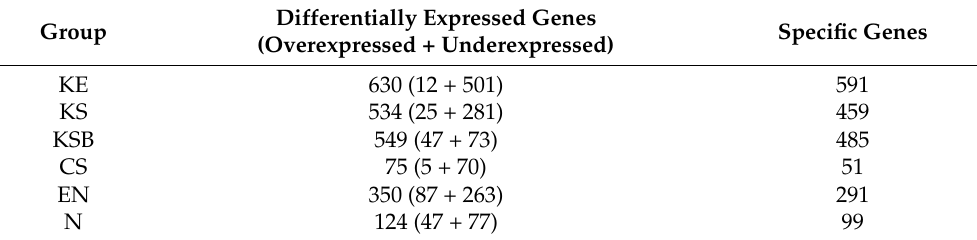
Table 2. Results of the differential expression analysis performed on each group against all other data, considered